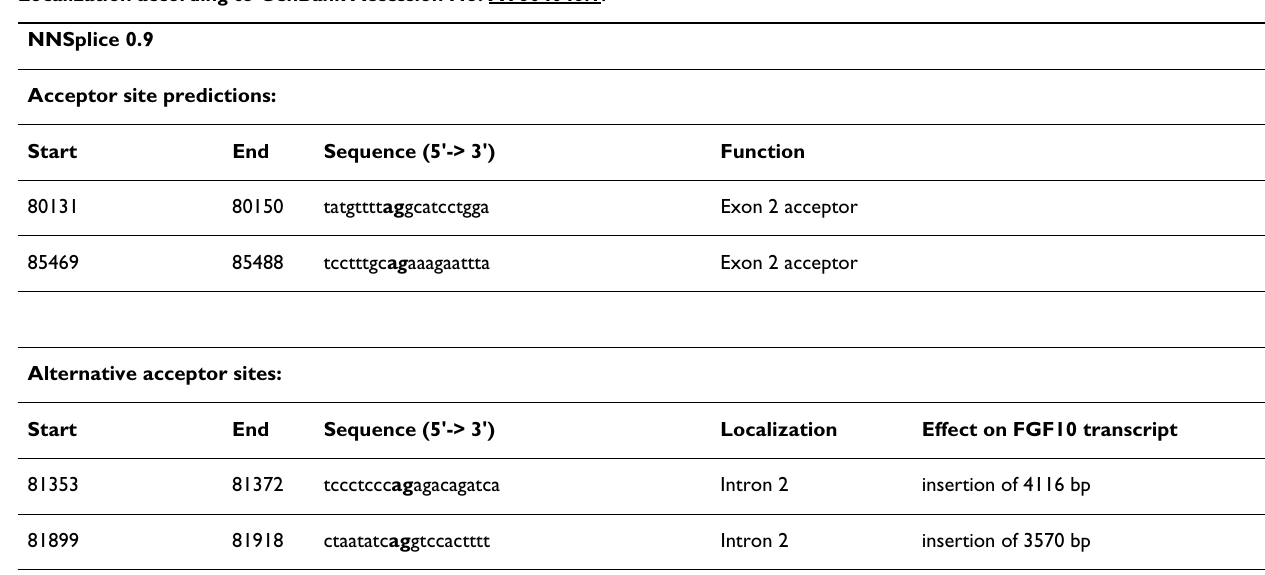
Table 2: Splice site prediction with NNSplice 0.9 and NetGene2 v. 2.4. Both algorithms anticipate the loss of the regular splice acceptor site of FGF10 exon 3 caused by the c.430-1, G > A aberration. Several alternative acceptor splice sites are proposed. Localization according to GenBank Accession No.